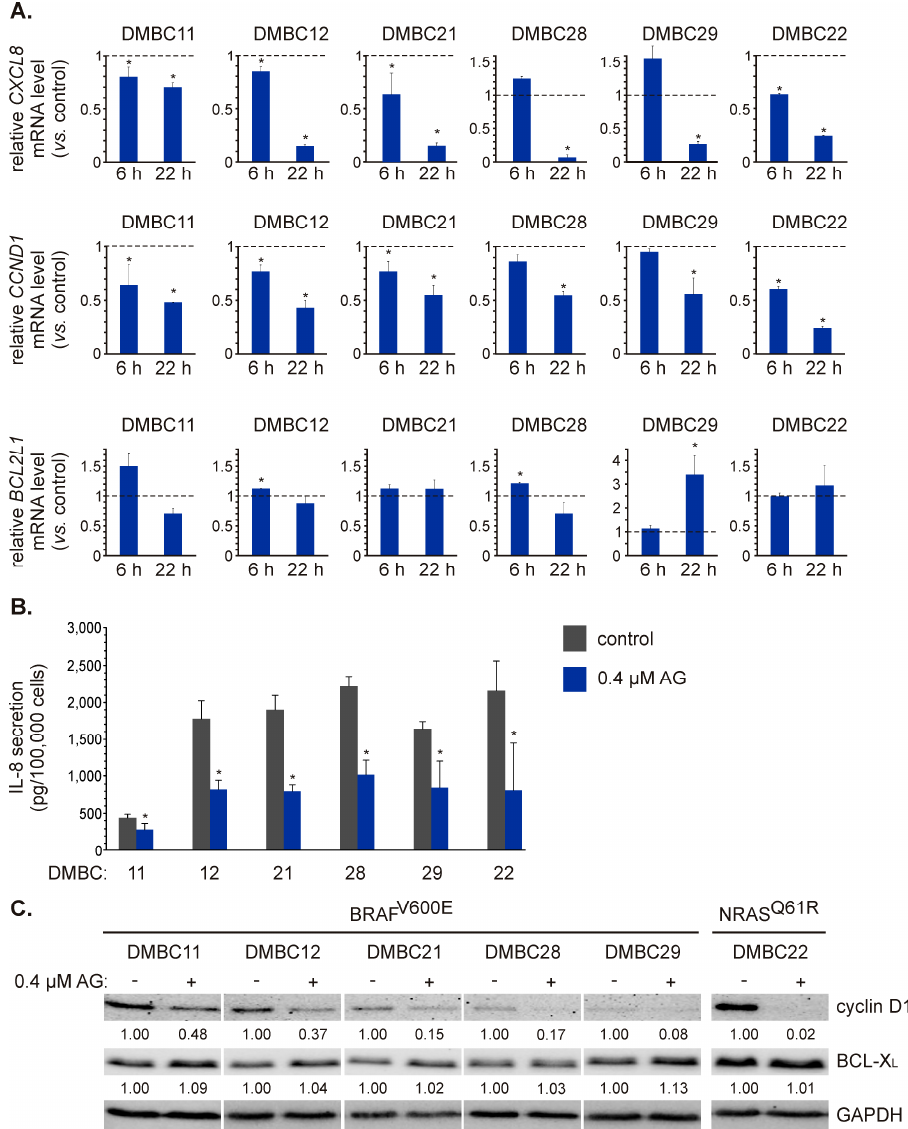
Figure 4. The effect of 17-aminogeldanamycin (AG) on mRNA and protein levels of NF- κ B-dependent genes in melanoma cells of the BRAF V600E or NRAS Q61R subtype. ( A ) The transcript levels of CXCL8 ( IL-8 ), CCND1 (cyclin D1), and BCL2L1 (BCL-X L ) were assessed by qRT-PCR after 6 and 22 h and shown relative to the control. Data presented are mean ± SD; n = 3 (* p ≤ 0.05 vs. control). ( B ) Samples of the culture medium were collected after 24 h of cell incubation with 0.4 µM AG. The protein levels of IL-8 were determined by enzyme-linked immunosorbent assay (ELISA). Data presented are mean ± SD; n = 3 (* p ≤ 0.05 vs. control). ( C ) The protein levels of cyclin D1 and BCL-X L were determined by Western blotting after 24 h. GAPDH was used as a loading control. The relative levels of cyclin D1/BCL-X L versus GAPDH are shown below the blots as an average of two independent experiments.